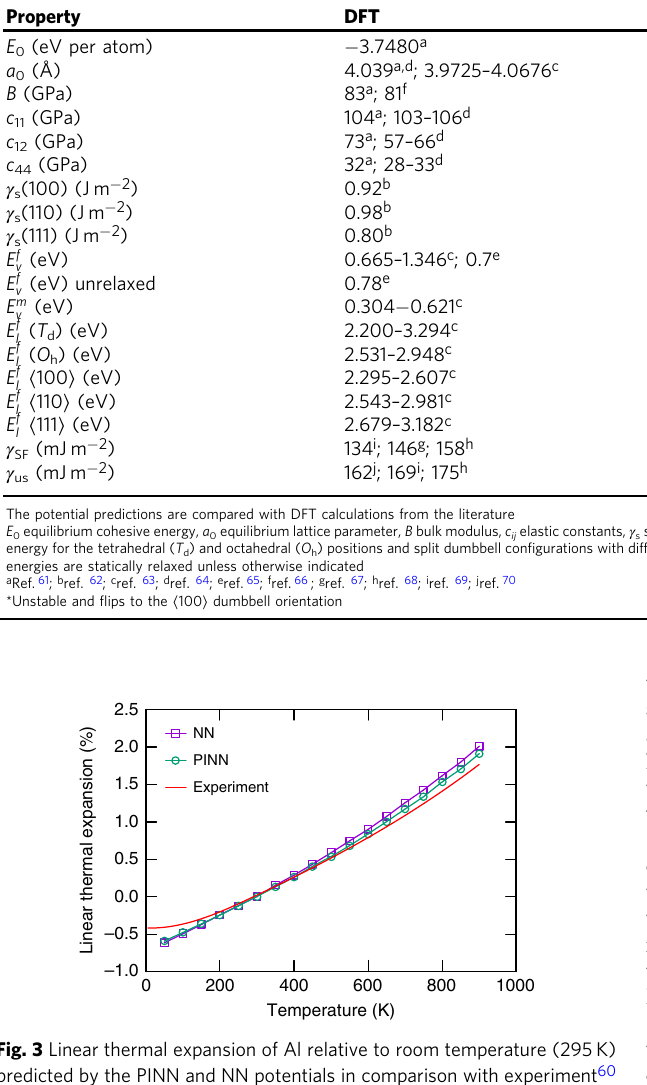
Table 2 Aluminum properties predicted by the PINN and NN potentials Property DFT